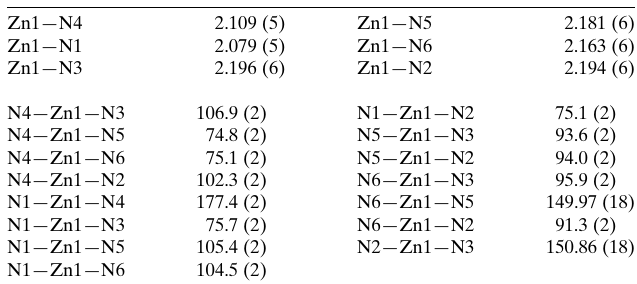
Table 1 Selected geometric parameters (A˚ , (cid:4) ).